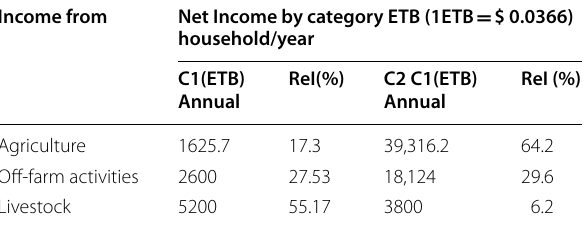
Table 5 Relative forest income (%)against the total sources of income for indigenous (C1) and